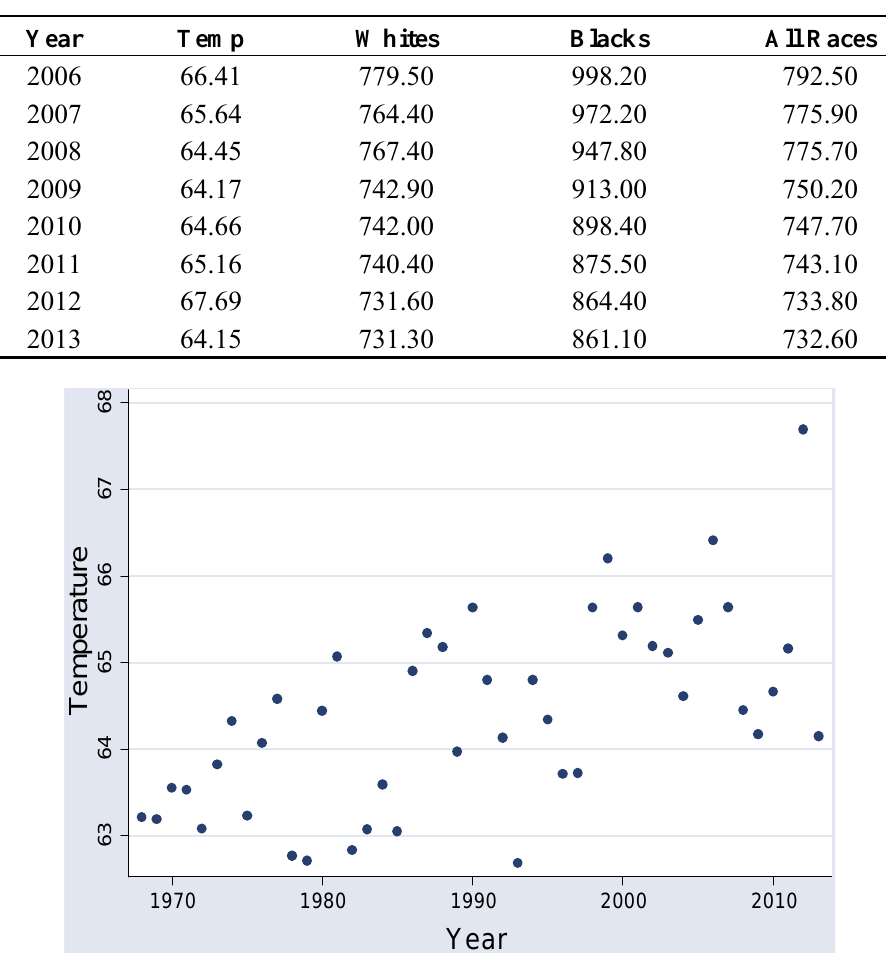
Figure 1. Temperatures by year for continental U.S., 1968–2013.